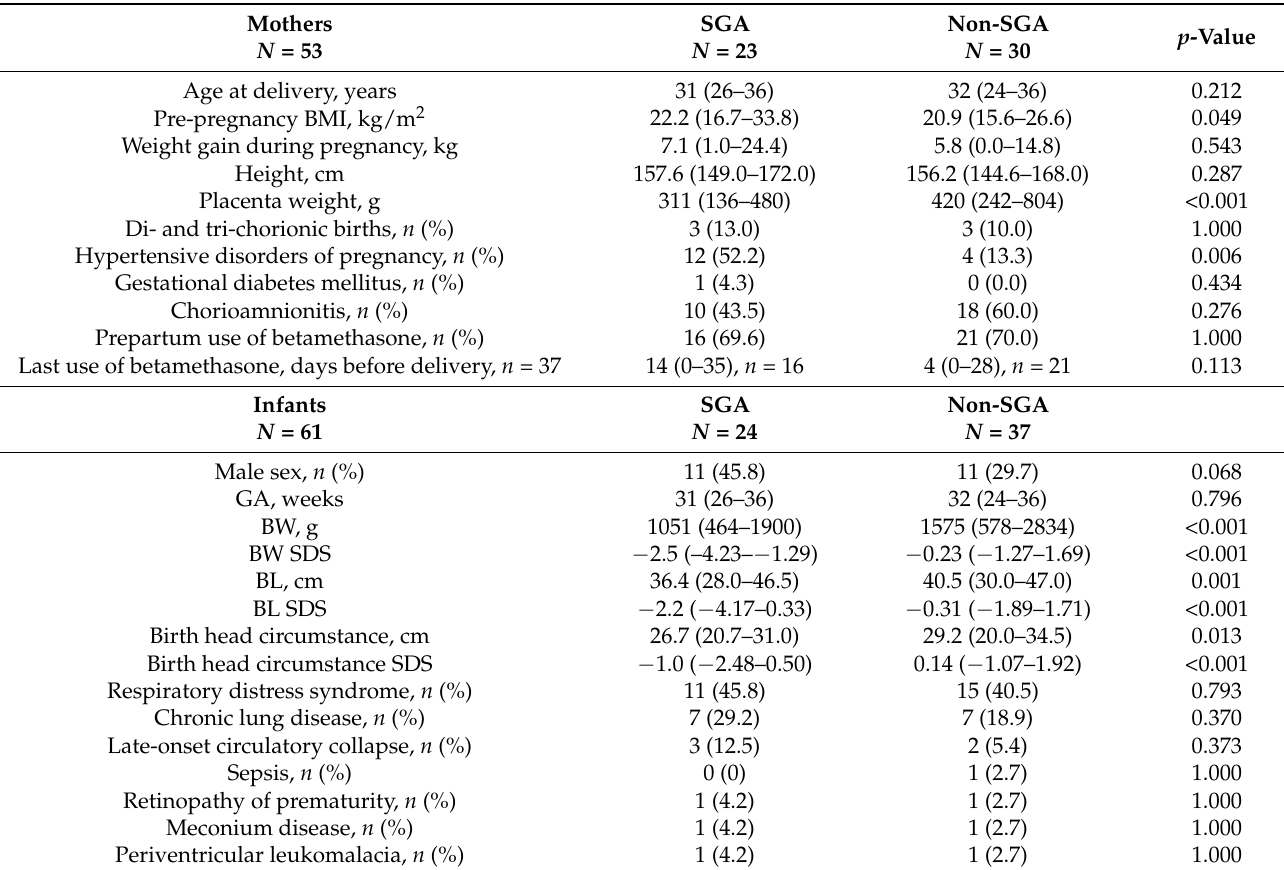
Table 4. Clinical characteristics of SGA and non-SGA groups.